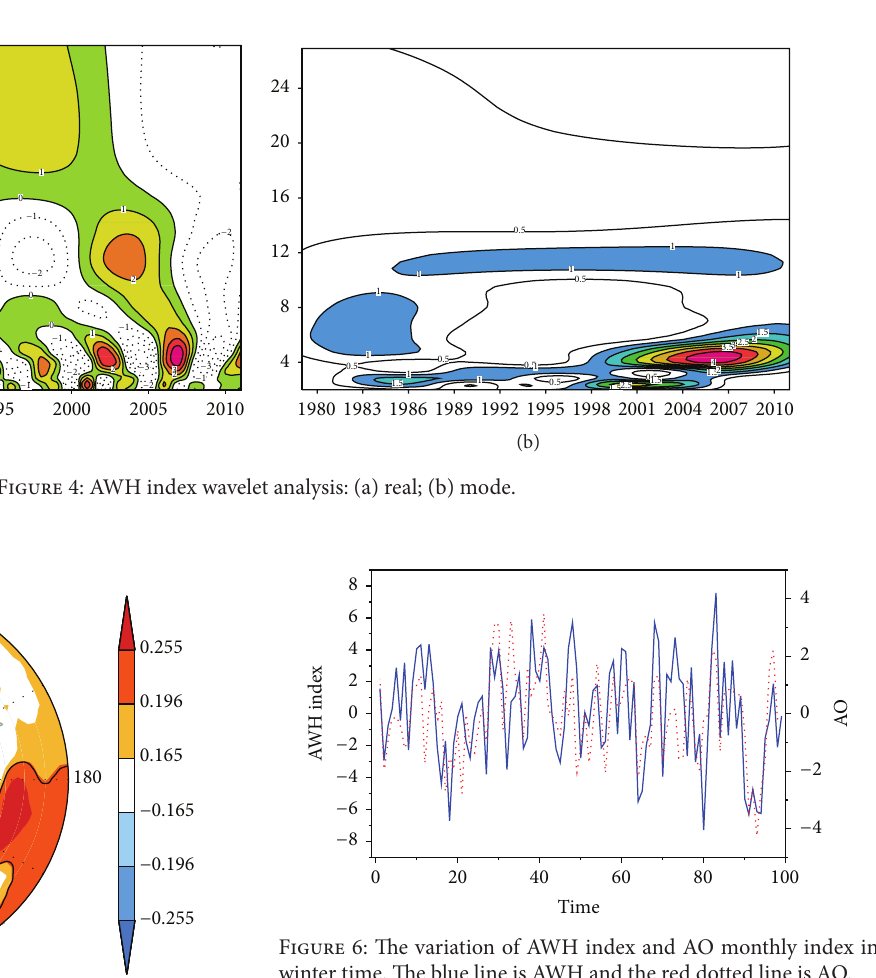
Figure 3: The variation of AWH index: the dotted line is 4-point running mean.